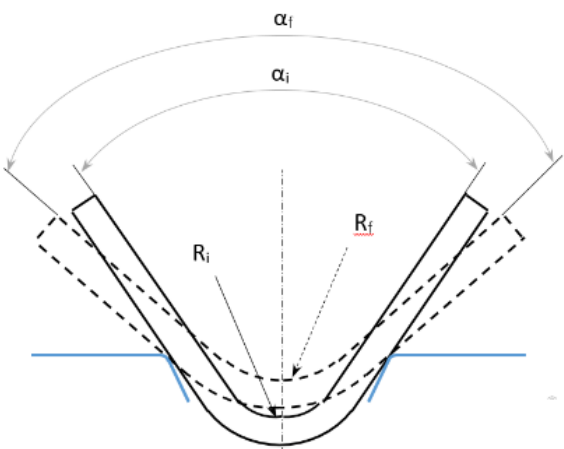
Fig. 1. Angles before and after punching